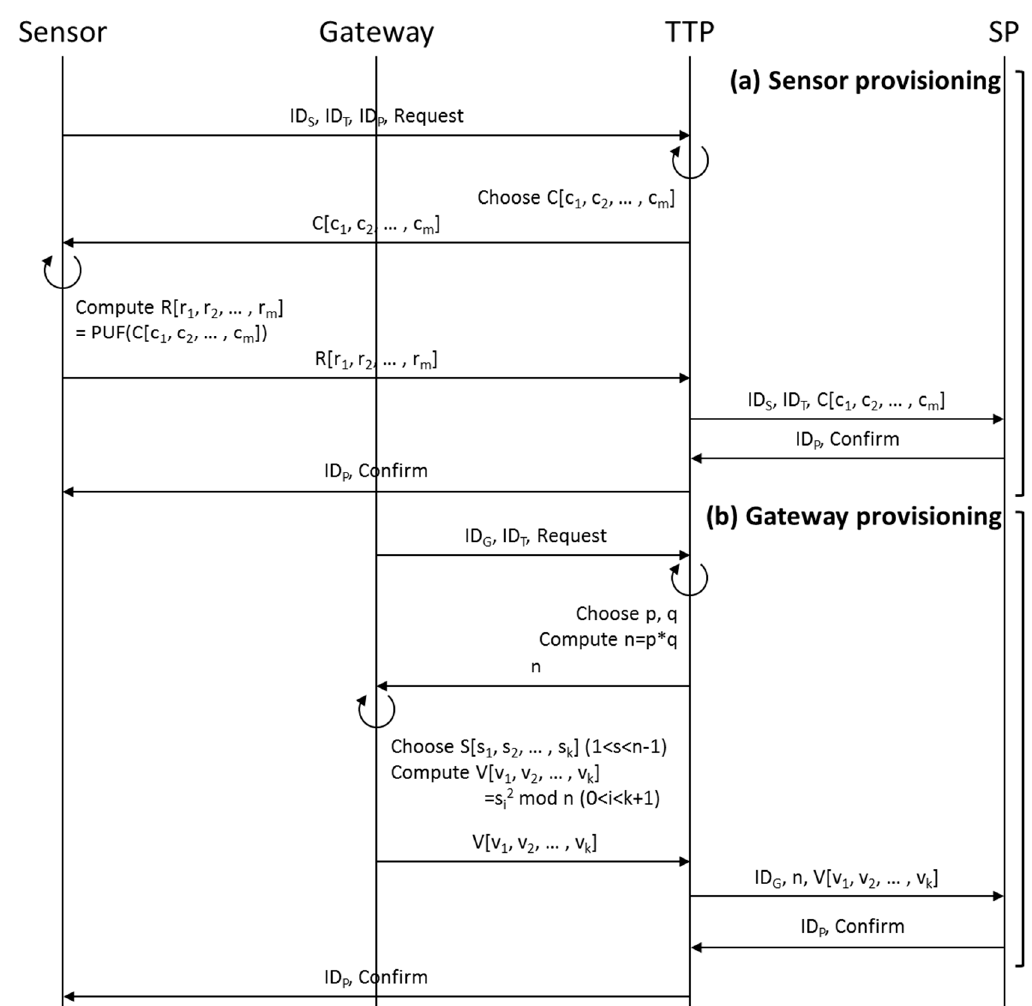
Figure 3. Provisioning phase: ( a ) sensor provisioning; ( b ) gateway provisioning.